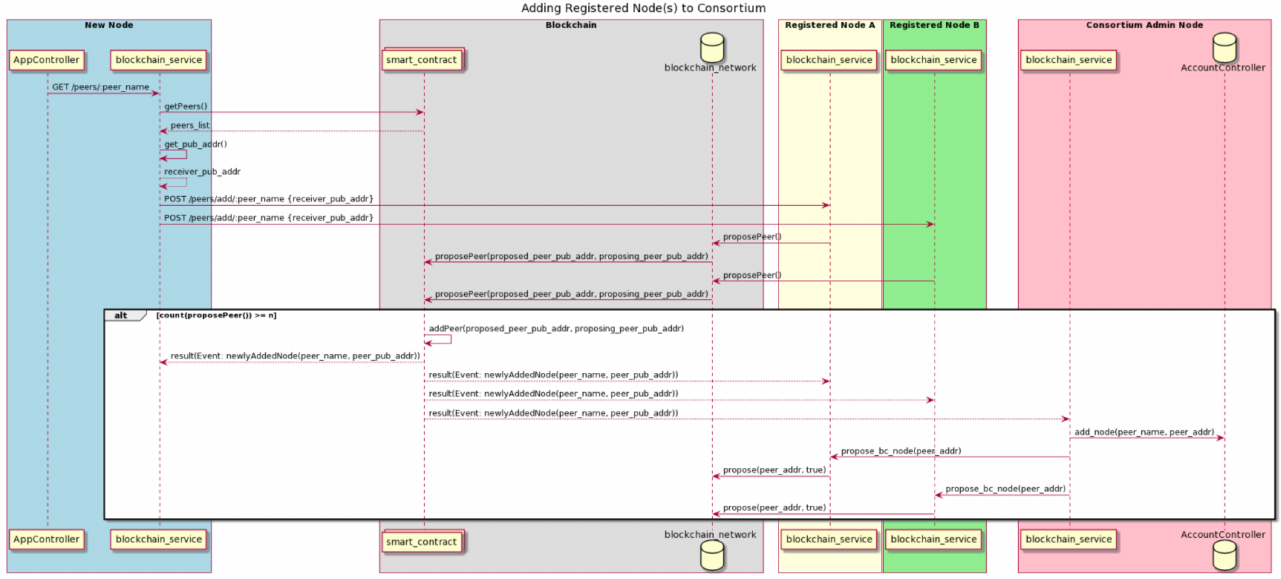
Figure 11. Adding New Registered Nodes to Enterprise